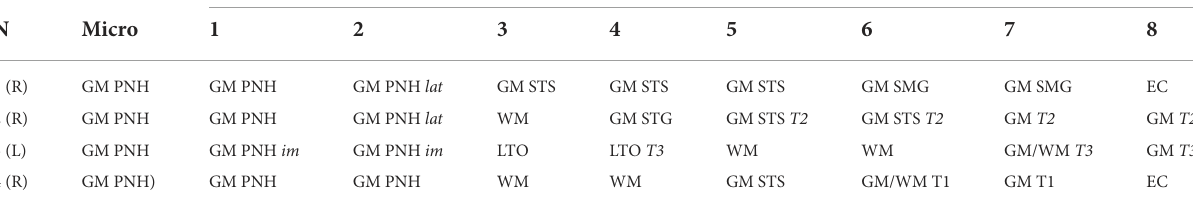
TABLE 2 Localization of electrode